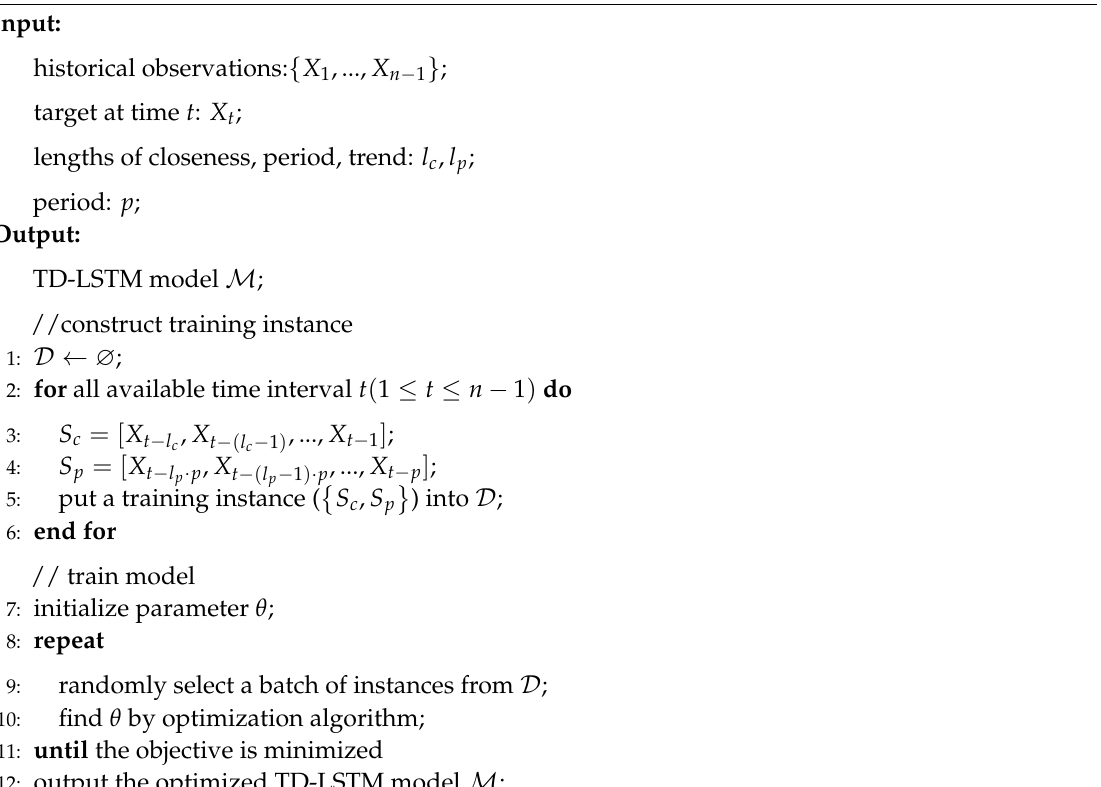
Algorithm 1 Training of TD-LSTM